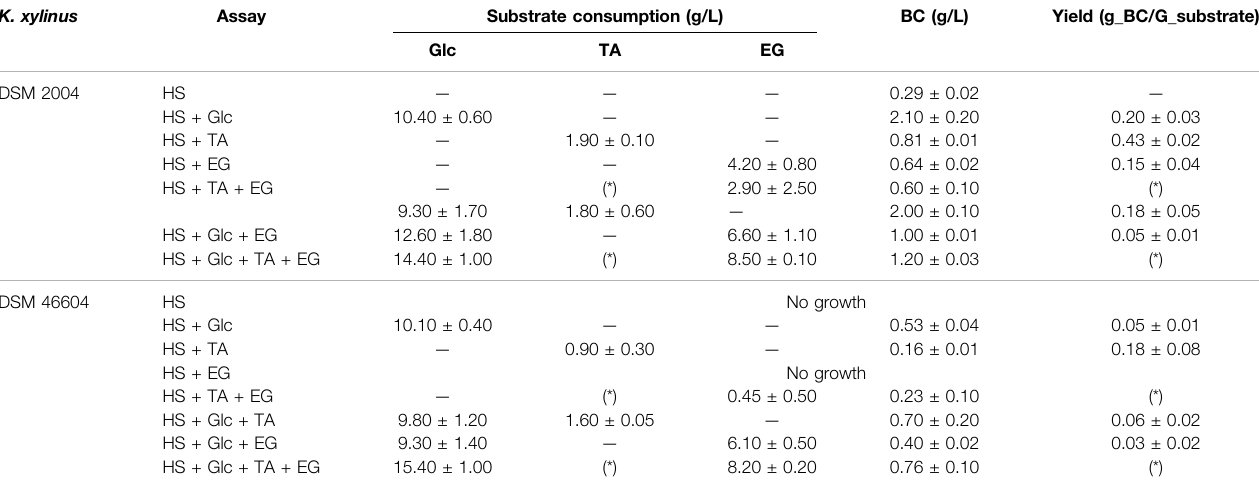
TABLE1| Substrateconversion,BCproduction,andyieldofBConasubstratebasisfor K.xylinus DSM2004andDSM46604grownontheHSmediumsupplementedwith glucose, TA, and/or EG. K. xylinus